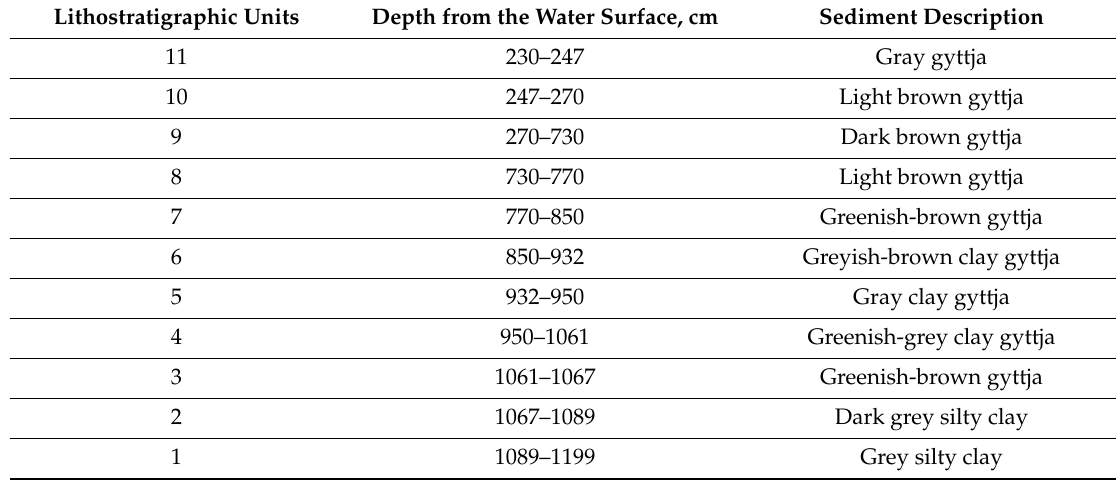
Table 2. Sediment description of lithostratigraphical units.